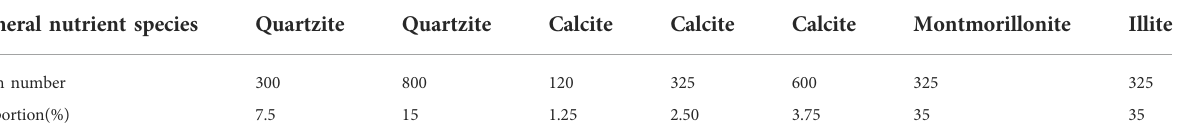
TABLE 2 Mix proportion of weak